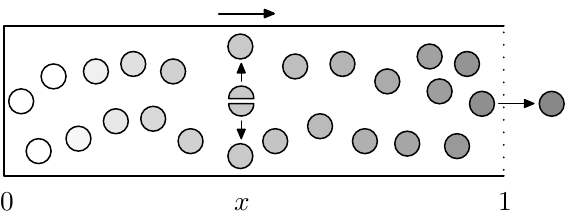
Fig. 5. Scheme of maturation and division of cells in the bone